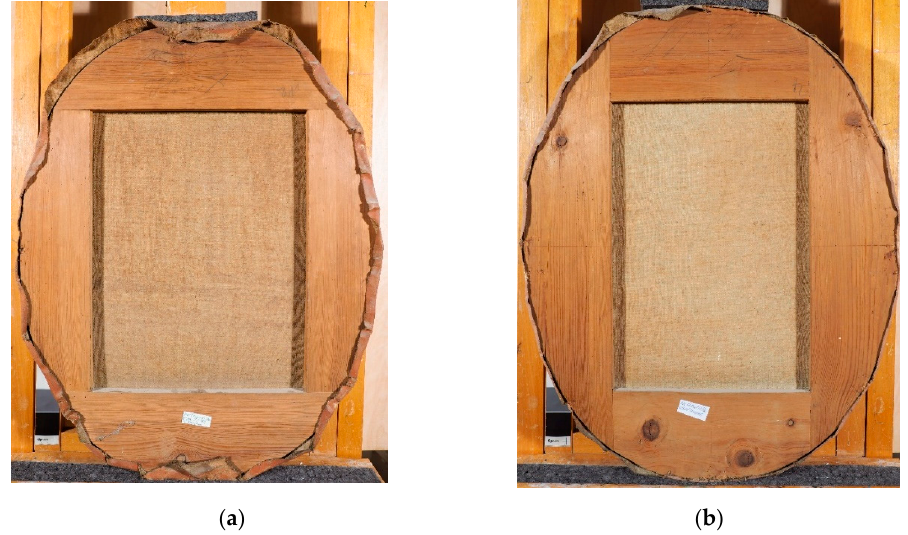
Figure 2. ( a ) The original strainer on the verso of J.B. Neergaard (SV1). The reverse facing side shows the full length of the upper and lower bar and is opposite to ( b ). Similar positioning is seen on the strainer of M.C. Buchwaldt (SV3). ( b ) The original strainer on the verso of A.M.B. Neergaard (SV2). The reverse facing side shows the full height of the sidebars and is opposite to ( a ). Similar positioning is seen on the strainers of J.P.B. Neergaard (SV4), J. Moltke (SV5) and E. Moltke (SV6). The strainer also displays incised lines across the centre of each member which represent the major and minor axes.